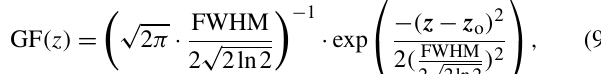
Table 2. Summary of satellite vs. 125HR comparison results. SEM refers to the standard error in the mean, i.e. σ √ Instrument (retrieval